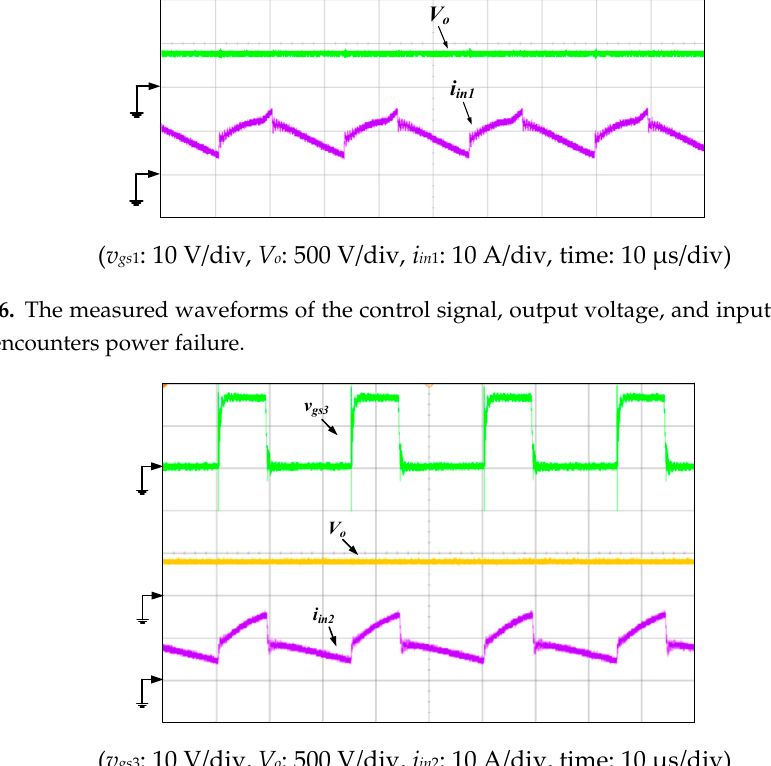
200 Figure 19. The conversion efficiency of the proposed converter.